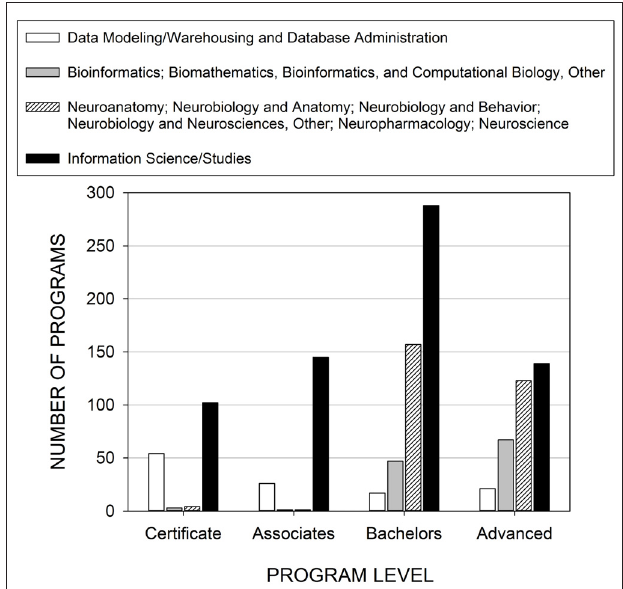
FIGURE 1 | Number of extant programs in the US offering training in skills needed in big data neuroinformatics. Only two US institutions offered programs with all four categories. Methodology is similar to that described in Ramos et al.